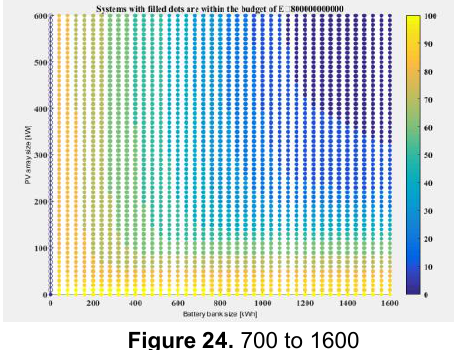
Figure 24. 700 to